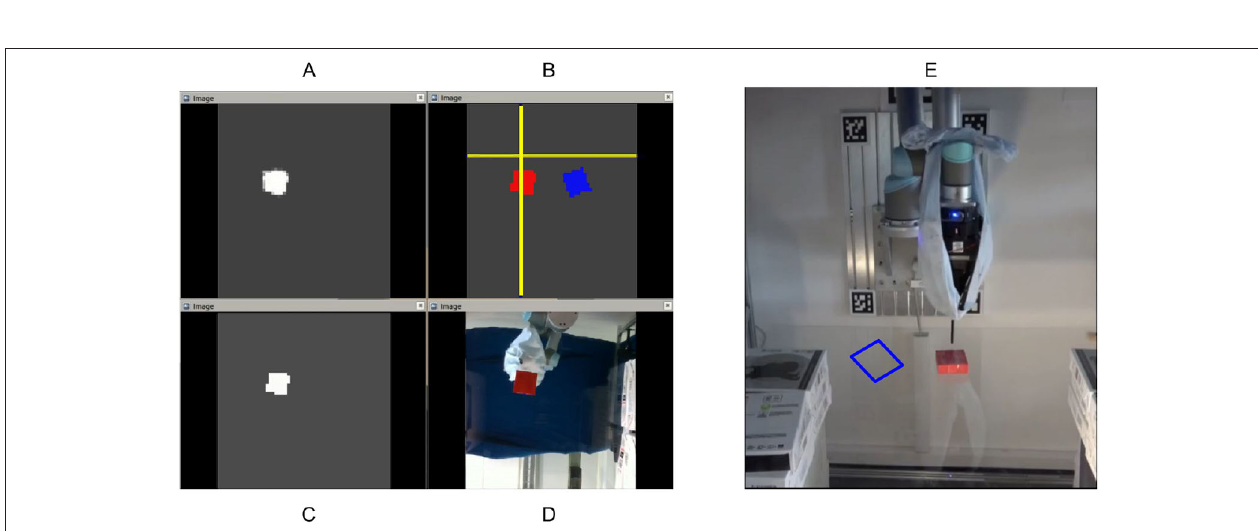
FIGURE 8 | The layout of the visualization tool in the experiment. A comprehensive view is given in (B) : the blue and red rectangles represent the target and real-time object pose, respectively, the yellow cross represents the pusher position. (A,C) are the real-time object masks after the color filter and the mask reconstruction from the decoder. We find it quite useful to visualize the two masks during debugging for the experiment. (D) shows what the robot sees from the bottom camera and (E) is the front